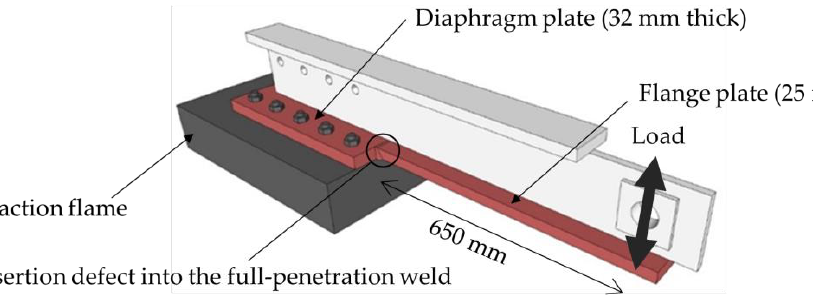
Figure 2. Configuration of the beam-to-diaphragm joint specimen.